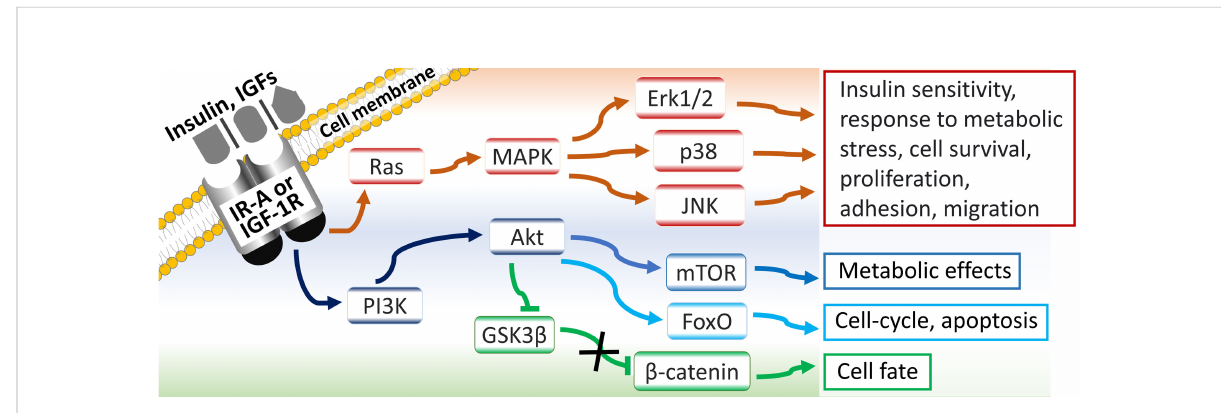
FIGURE 2 Signaling pathways and physiological roles of IR-A and IGF-1 receptors.